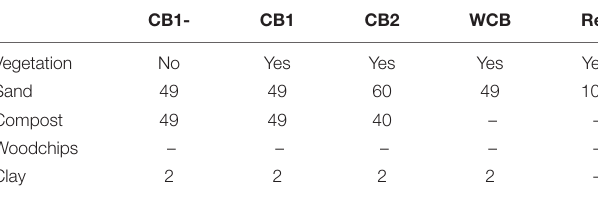
TABLE 1 | Barrier composition (%